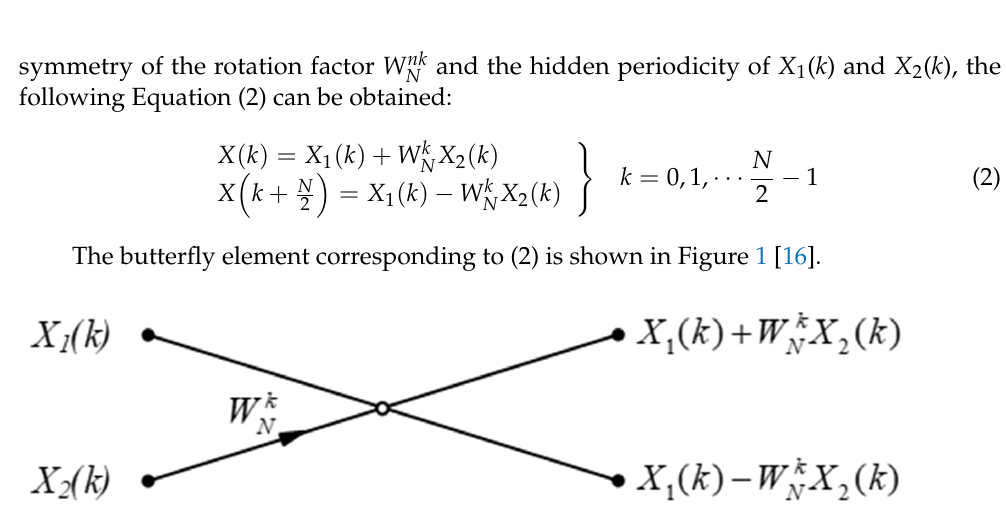
Figure 1. Butterfly element.